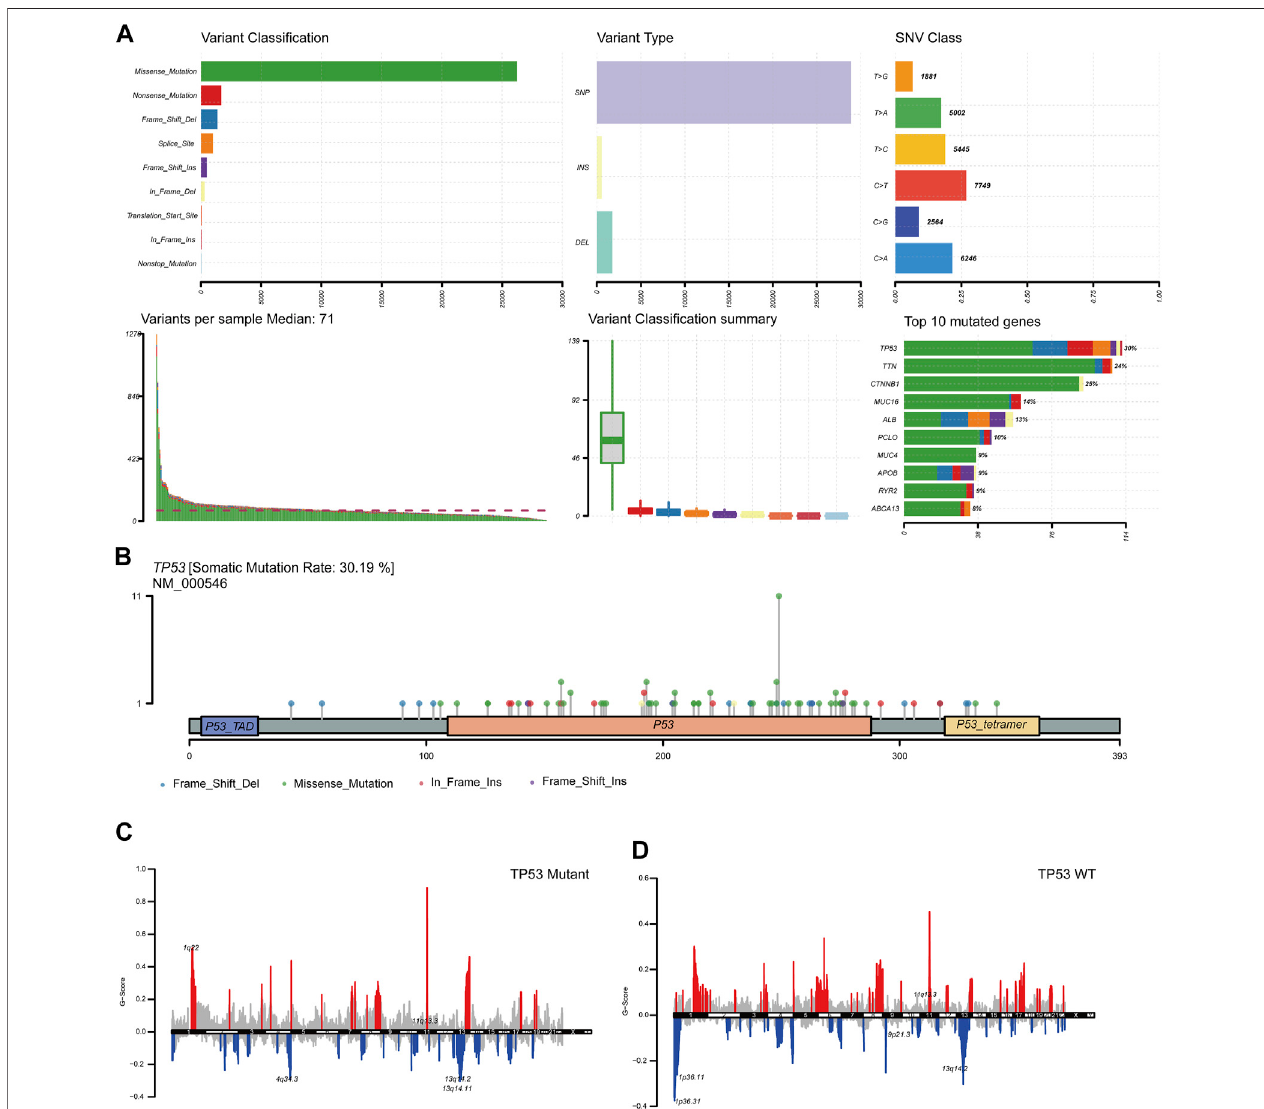
( Figure 1B ). Simultaneously, based on the mutation status of TP53, we divided the CNV data of TCGA-LIHC into TP53 mutation and wild-type groups, and found that both TP53-MT and TP53-WT groups had a large CNV regardless of the states of TP53. The signi fi cantly ampli fi ed regions in TP53-MT group included 1q22 and 11q13.3, and signi fi cant